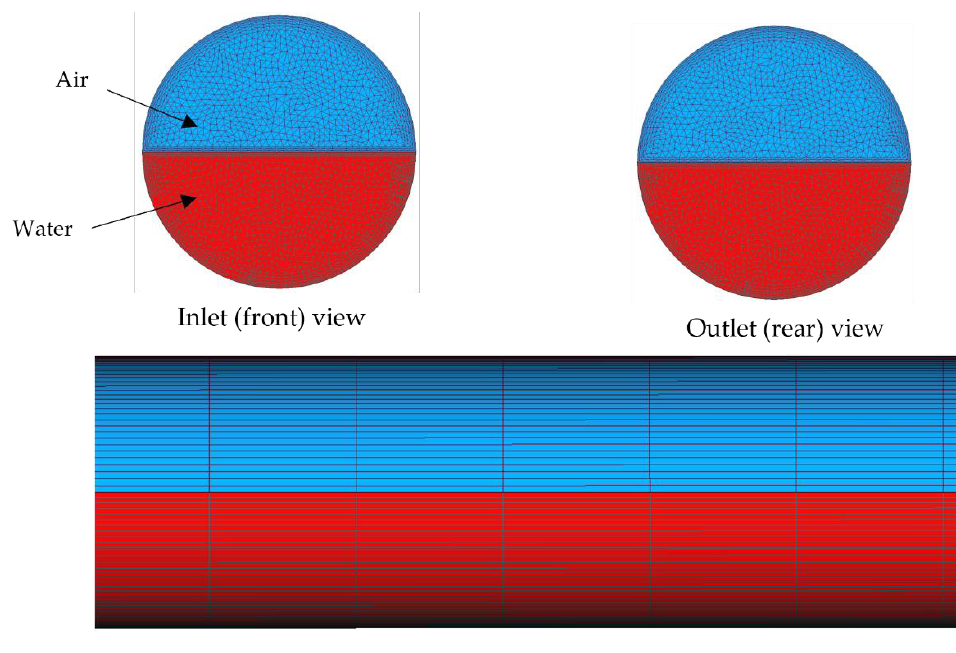
Figure 2. Mesh development of the piping system.